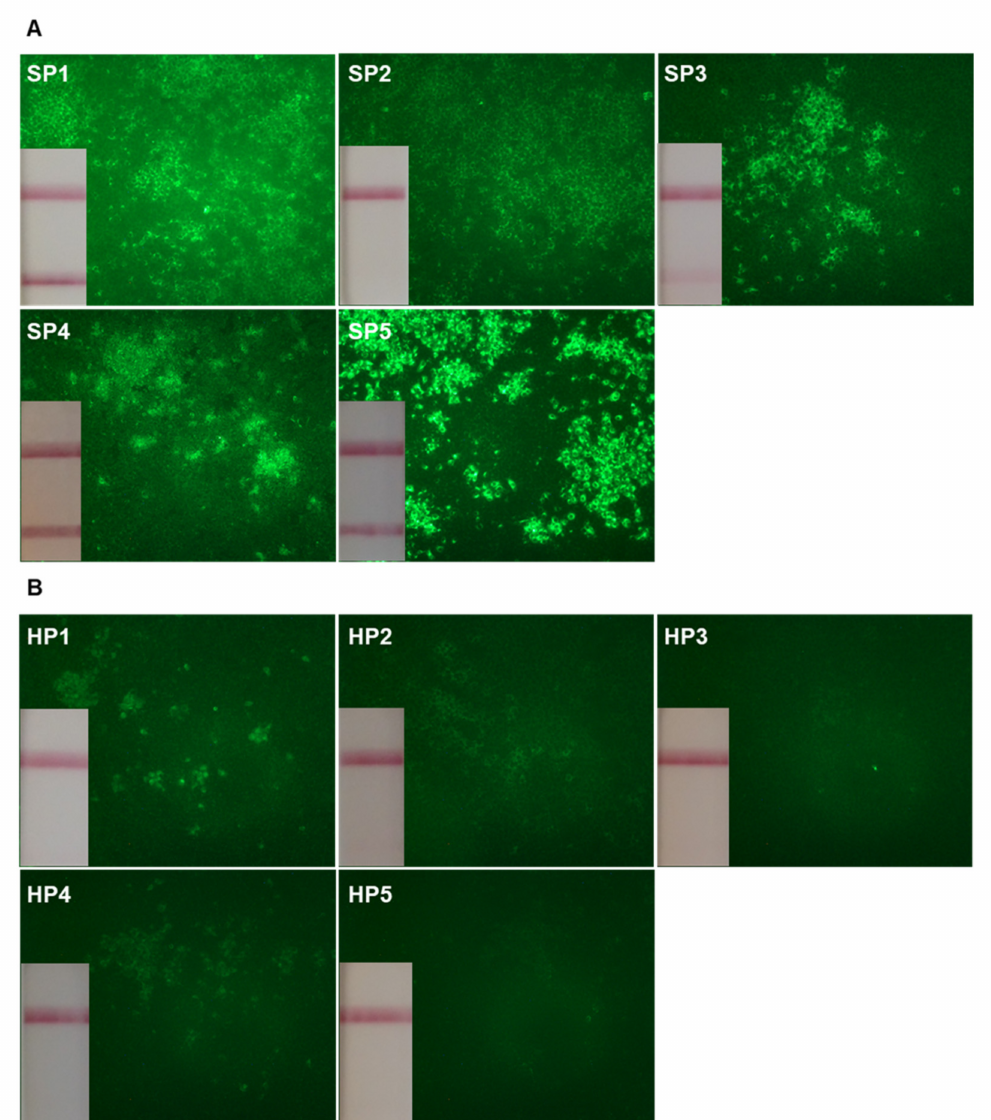
Figure 1. Detection of antiviral antibodies in the plasma of convalescent COVID-19 patients. Indirect immunofluorescence staining was performed on fixed SARS-CoV-2 infected BGM cells, using diluted plasma from severe patients ( A ) and from convalescent healthcare personnel ( B ) of the disease. For each plasma tested, the results of the Wantai SARS-CoV-2 Ab rapid test obtained are inserted at the bottom left of the immunofluorescence